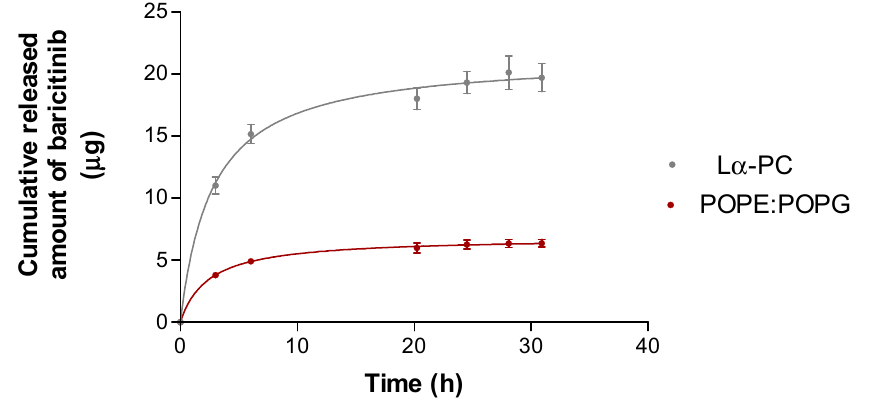
Figure 6. Release profiles of baricitinib from the liposomes POPE:POPG (1-palmitoyl-2-oleoyl-phosphatidylethanolamine: 1-Palmitoyl-2-oleoyl-sn-glycerol-3-phosphoglycerol (3:1, mol/mol), and L α -PC (L- α -phosphatidylcholine): baricitinib cumulative released ( µ g) vs. time (h). Results are expressed by mean ± SD (n = 5). Table 6. Best fit values in the kinetic modeling for the liposomal formulations and the statistical analysis by a t -Test between L α -PC and POPE:POPG. Significance level set at p < 0.05. Parameters